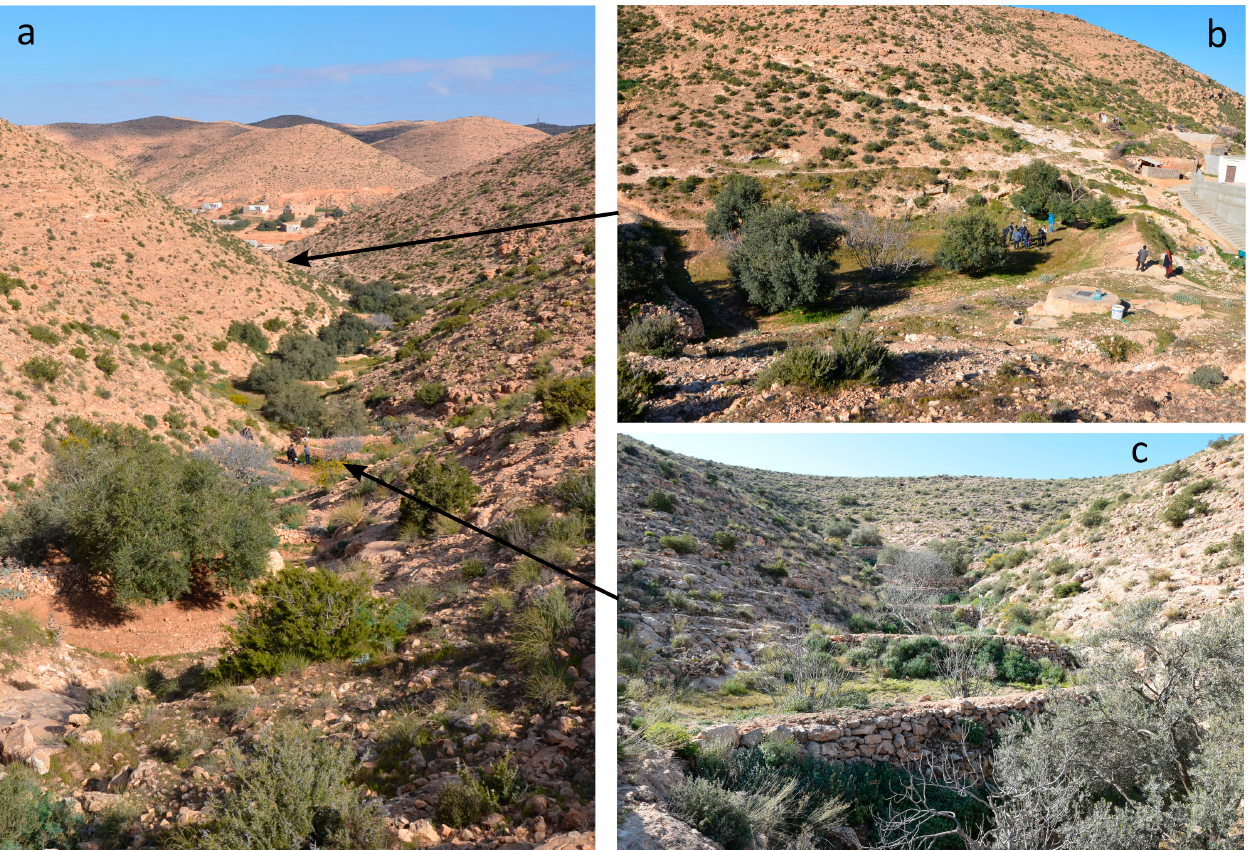
Figure 3. General view of the Dhara Waja ravine ( a ). View of downstream ( b ), and upstream Jessour ( c ). Photos: E. Reynard and T. Ben Fraj.